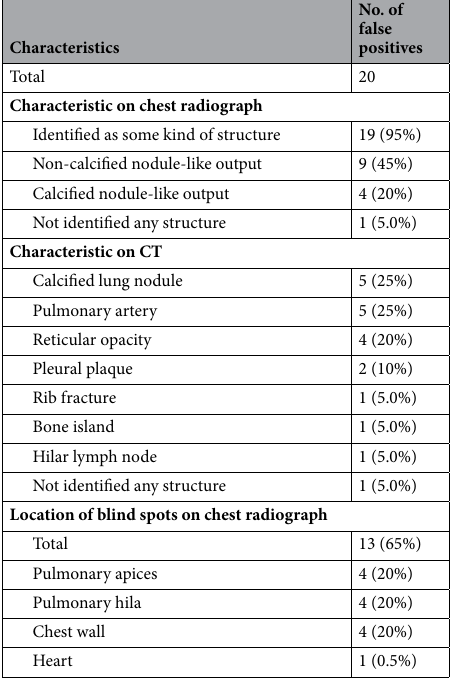
Table 3. False positive output characteristics assessed by radiologists in the test dataset.